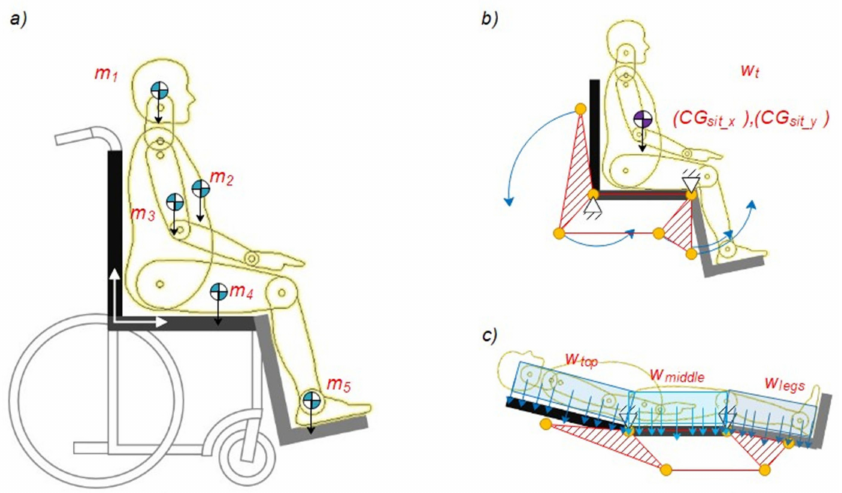
Figure 4. Proposed wheelchair mechanism design: ( a ) Wheelchair mainframes; ( b ) Movement of the wheelchair mechanism; ( c ) Wheelchair in the dorsal decubitus